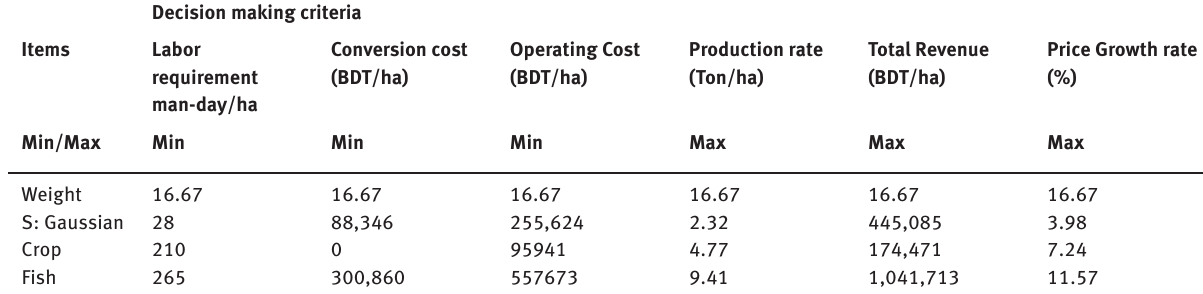
Table 2: Small farm land-use alternatives in equal weight criteria situation Decision making